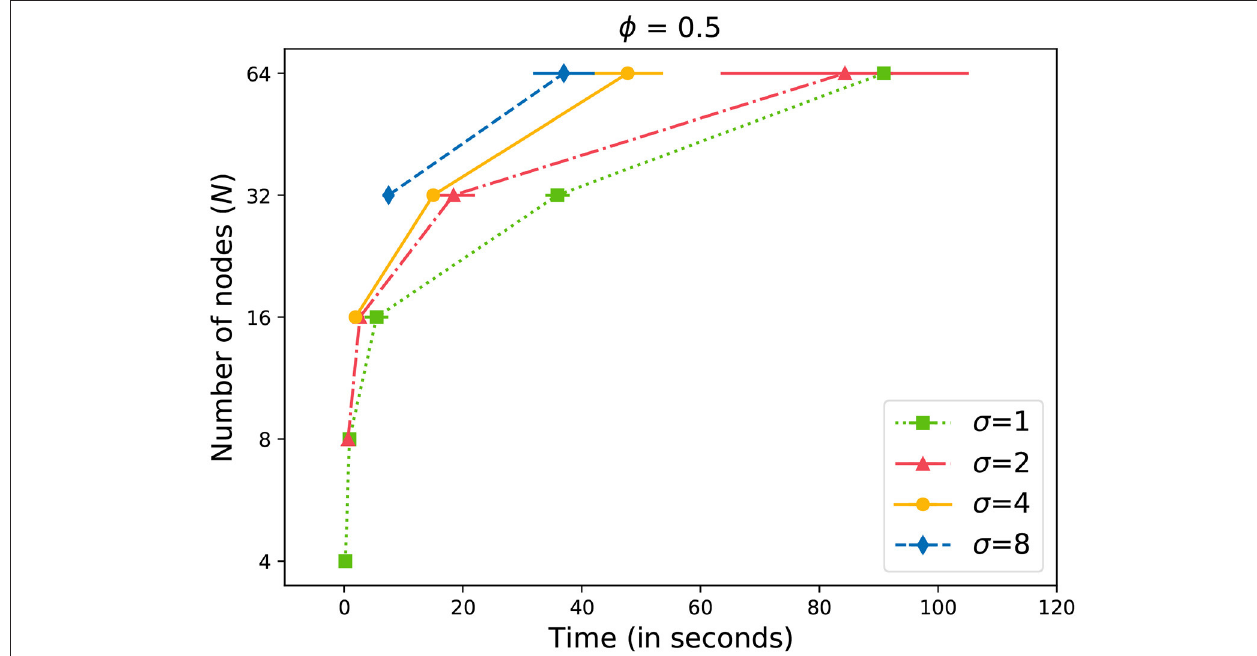
FIGURE 4 | Time to gossip a message with φ = 0.5.